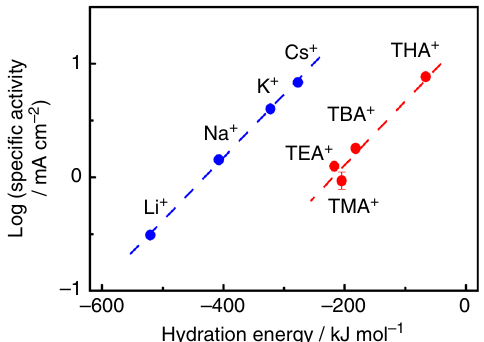
Fig. 4 Speci fi c oxygen reduction reaction activities and hydration energies of cations. Logarithm of the speci fi c oxygen reduction reaction (ORR) activities versus hydration energies of alkali metal cations 19 , tetramethylammonium cation (TMA + ), tetraethylammonium cation (TEA + ), tetra- n - butylammonium cation (TBA + ), and tetra- n -hexylammonium cation (THA + ). The hydration energies of tetraalkylammonium cations were calculated